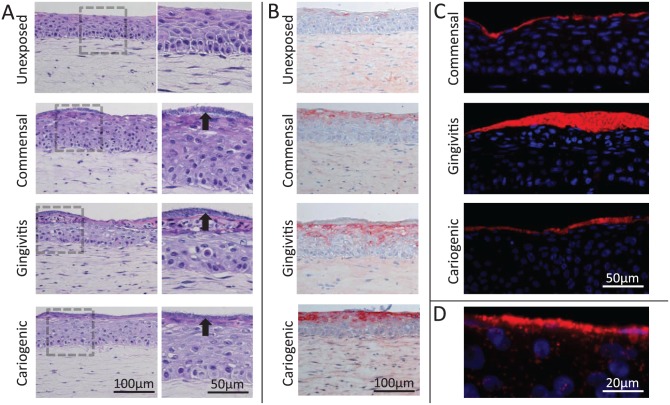
Histology of gingiva equivalents exposed to commensal, gingivitis, and
cariogenic biofilms. (A) Hematoxylin and eosin staining of
unexposed gingiva equivalents and gingiva equivalents exposed to the
different biofilms. A biofilm can be seen on top of the epithelium
(black arrows). The keratinocytes are enlarged and partly lose the
layered organization after biofilm exposure. (B) Elafin
expression is increased in the upper layers of the epithelium after
exposure to the different biofilms. (C) The fluorescence in
situ hybridization staining of the bacteria (red) shows a thick layer of
bacteria on top of the gingiva equivalents. Nuclei are stained with DAPI
(blue). (D) Enlargement of fluorescence in situ
hybridization staining shows localized superficial invasion of the
epithelium by bacteria.